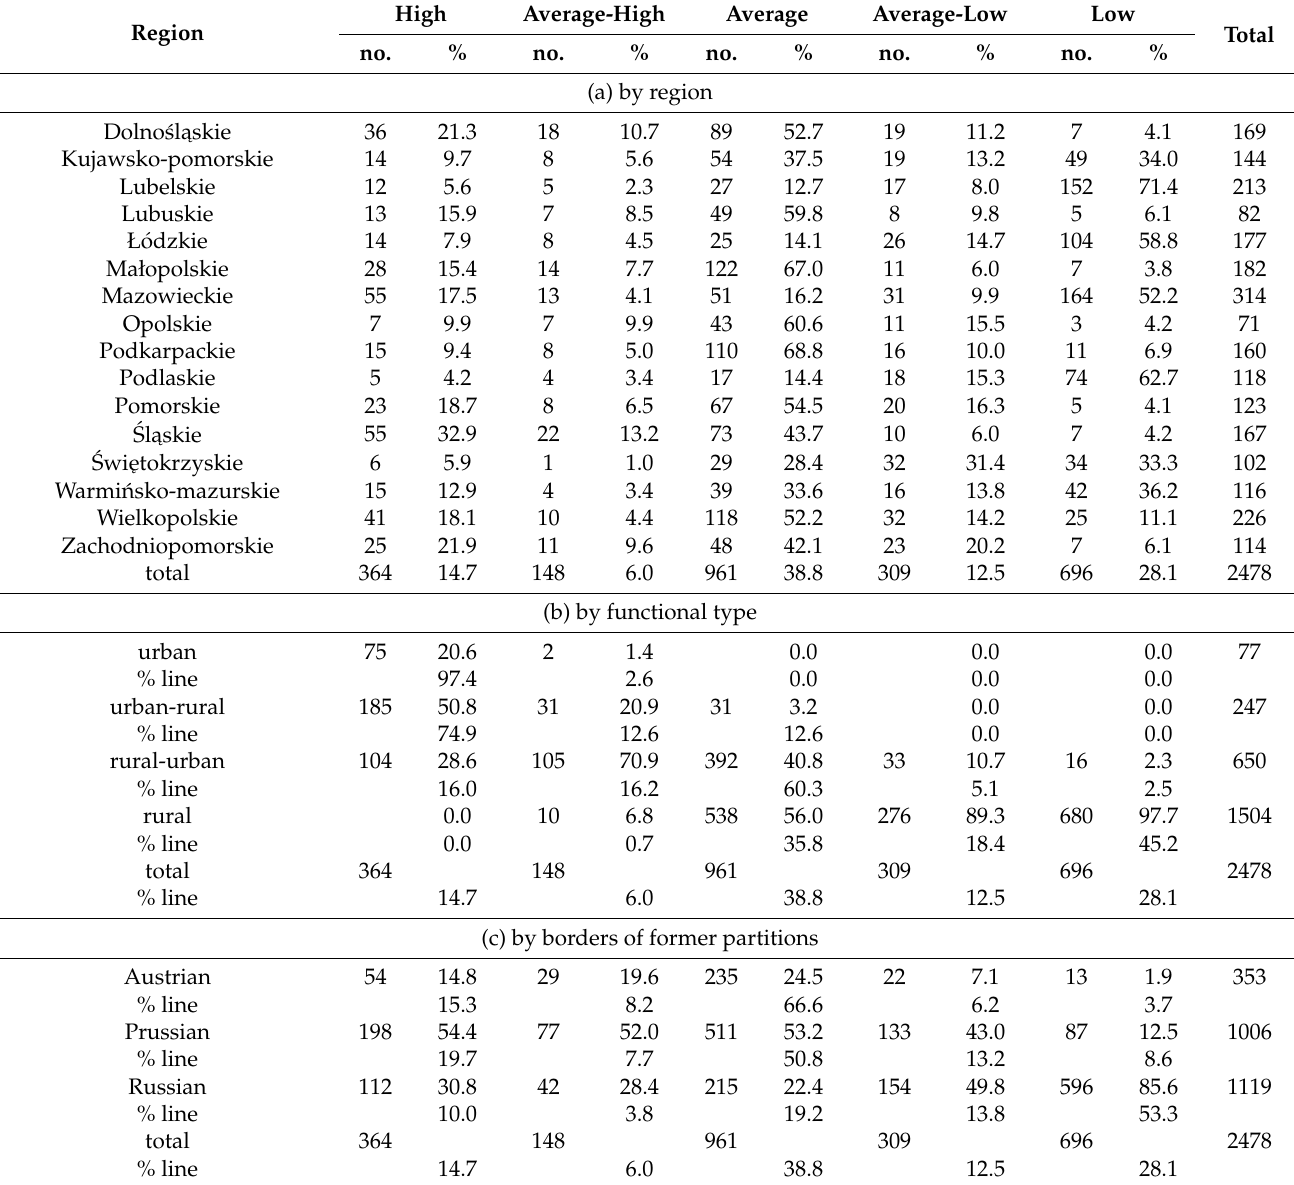
Table 2. Commune structure in terms of the level of socio-economic development in synthetic terms: (a) by region; (b) by functional type; (c) by borders of former partitions. Source: own elaboration.